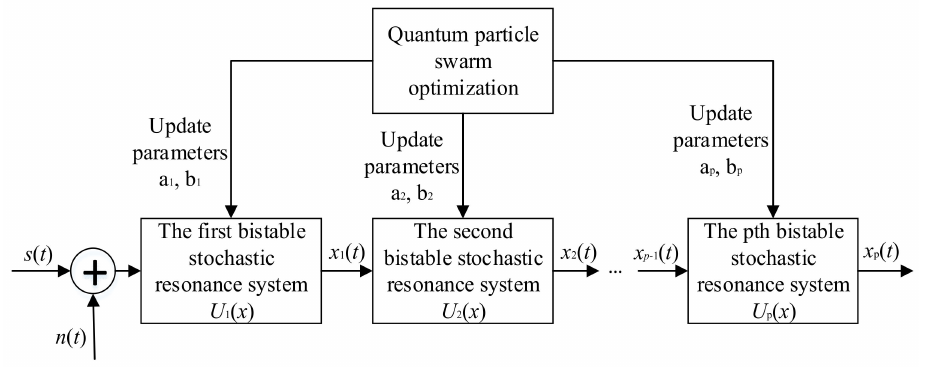
Figure 3. Adaptive cascaded bistable stochastic resonance